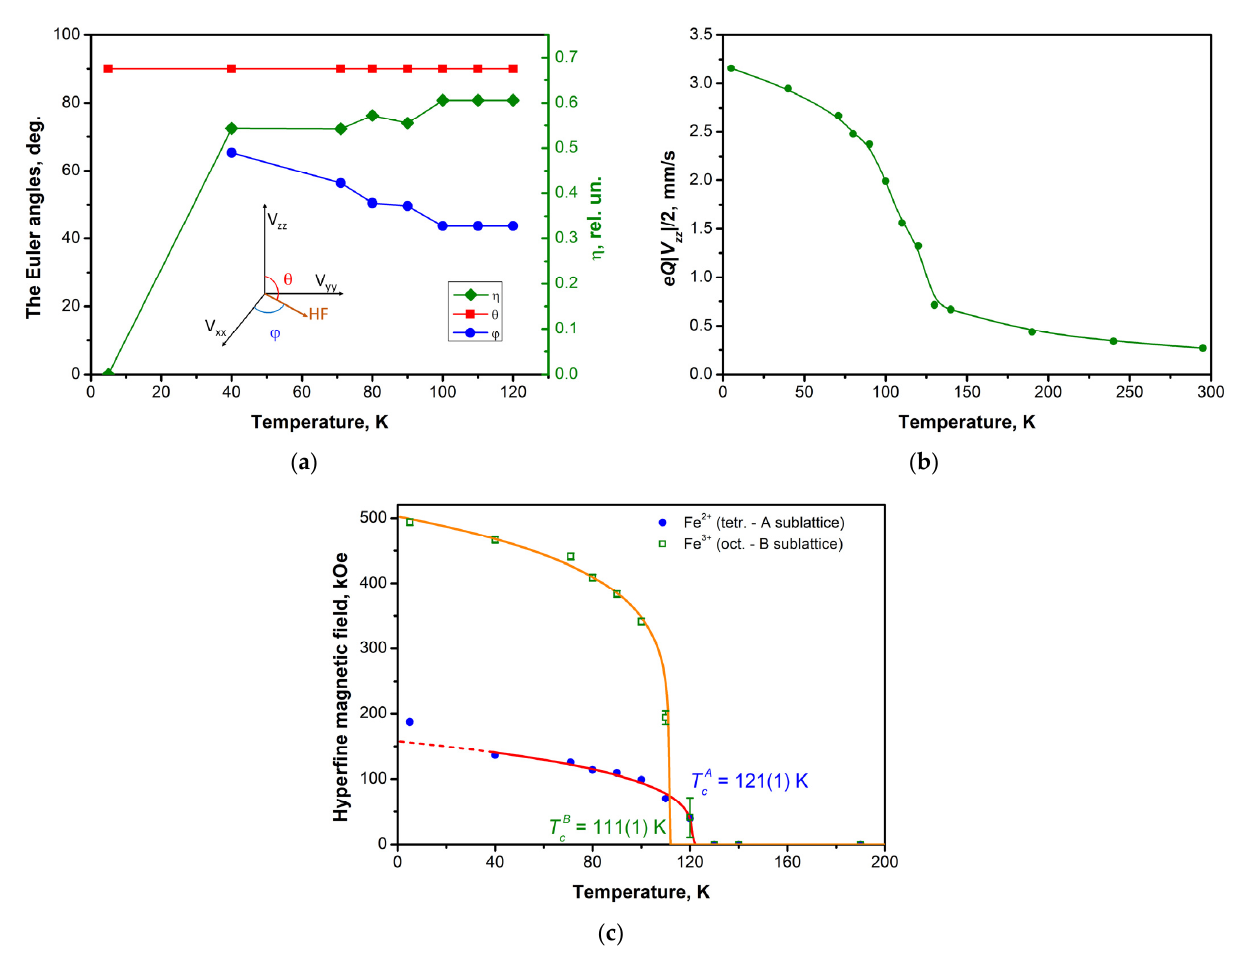
Figure 6. Temperature dependencies of Mössbauer spectra parameters: ( a ) the Euler angles θ (red curve) and ϕ (blue curve), the electric field gradient asymmetry parameter η (green curve) for ferrous ions; ( b ) the V zz component of the electric field gradient for ferrous ions; ( c ) hyperfine magnetic fields on the 57 Fe nuclei for the ferrous (blue points—experimental data, red curve—the model fit using Equation (1)) and ferric (green points and orange curve, respectively) ion components. The inset in ( a ) shows a schematic direction of the hyper fi ne magnetic fi eld (HF) in the EFG tensor principal axes frame.